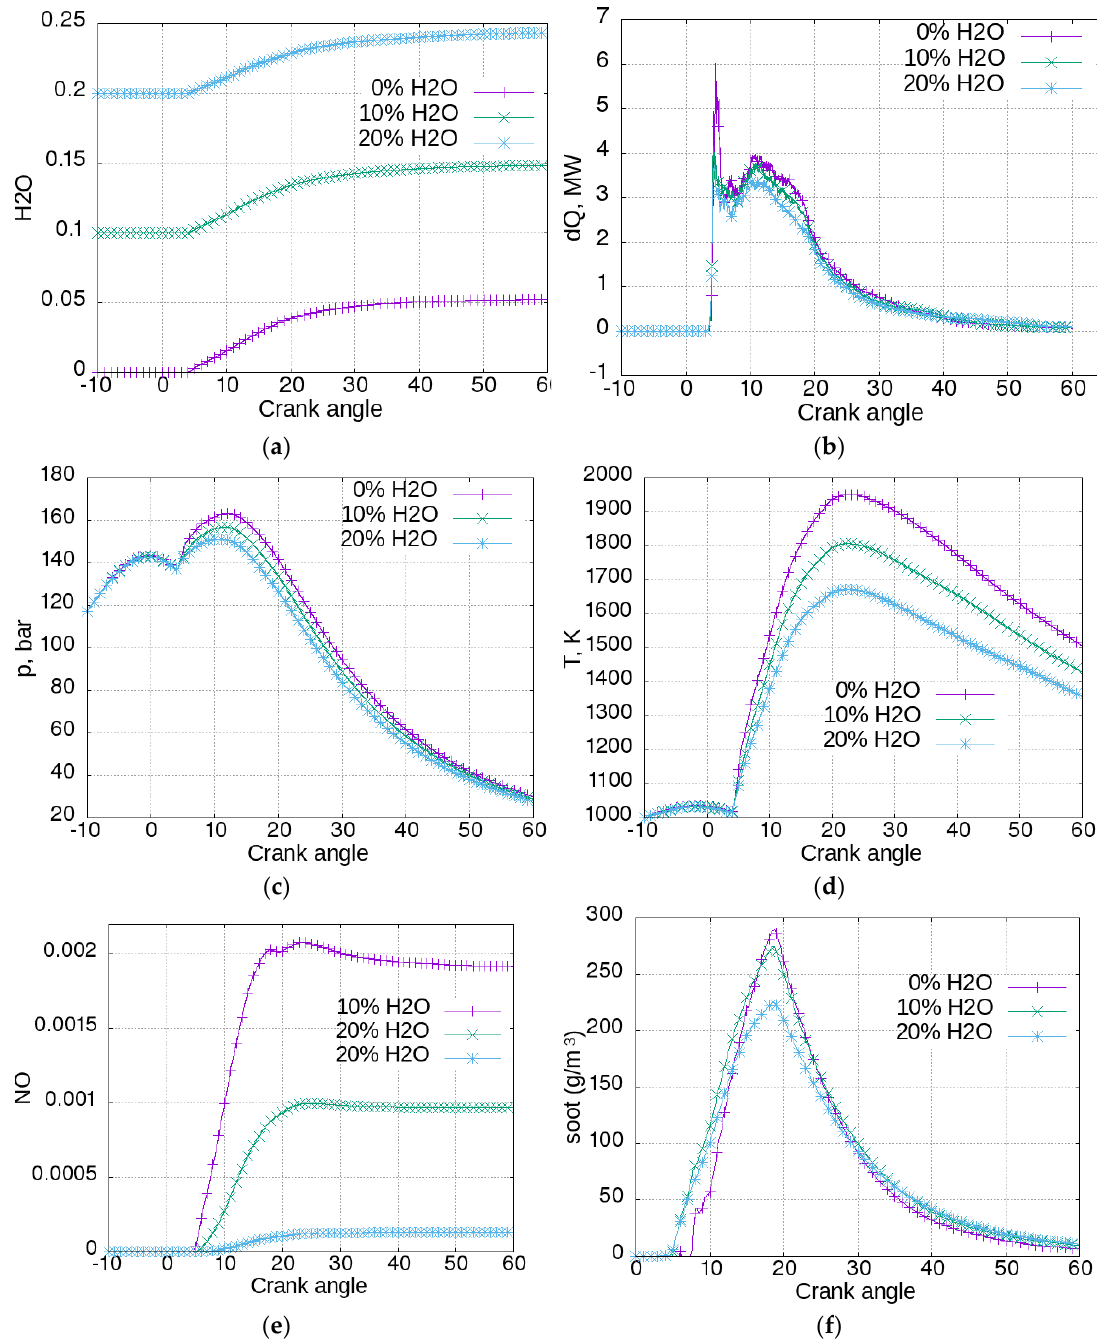
Figure 4. The influence of intake air humidification on the main combustion parameters: ( a ) Water vapor concentration; ( b ) Rate of heat release; ( c ) Cylinder pressure; ( d ) Cylinder temperature; ( e ) NO concentration; ( f ) Soot concentration.